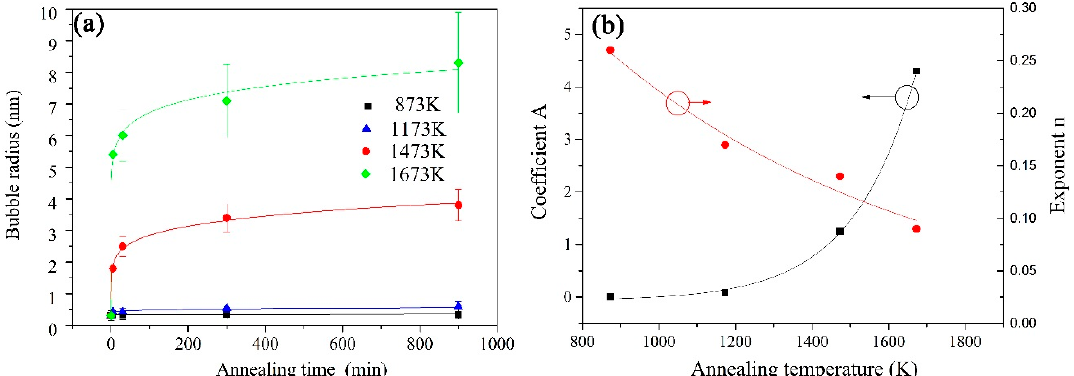
Figure 3. Curves showing the growth behavior of gas bubbles during the post-implantation annealing: ( a ) bubble sizes vs. annealing time; ( b ) coefficient A and exponent n vs. annealing temperature T .